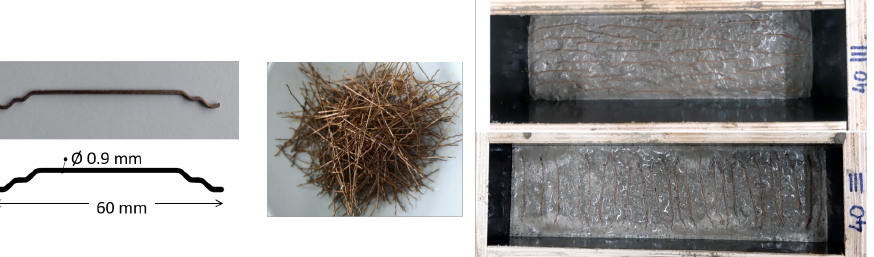
Figure 2. Photograph of steel fibers Dramix 5D ( left ) and photograph during the sequential concrete and fiber laying for orthotropic samples at the laboratory of the TU Dortmund ( right